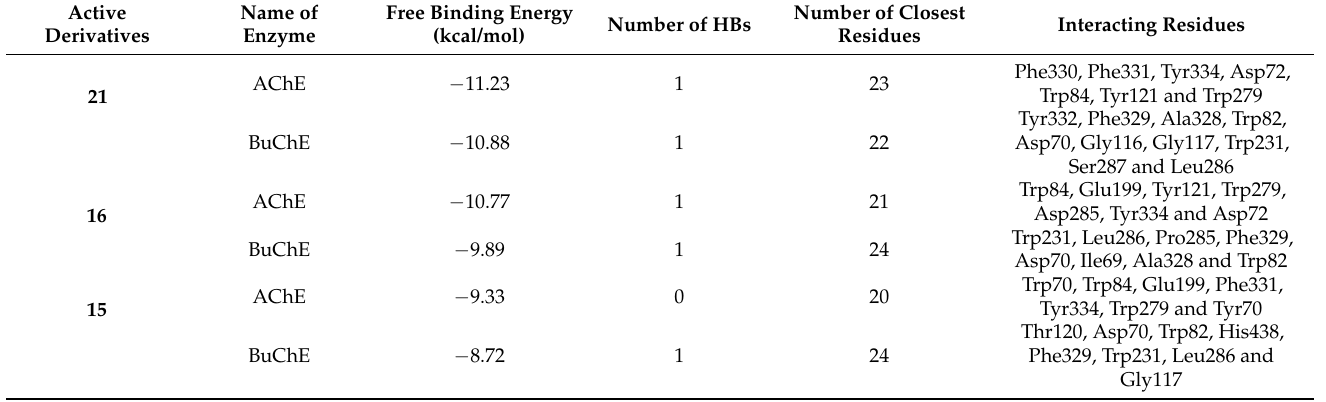
Table 2. The binding energies, numbers of hydrogen bonds, numbers of closest residues, and the interacting residues of the selected docked analogues into the active sites of both AChE and